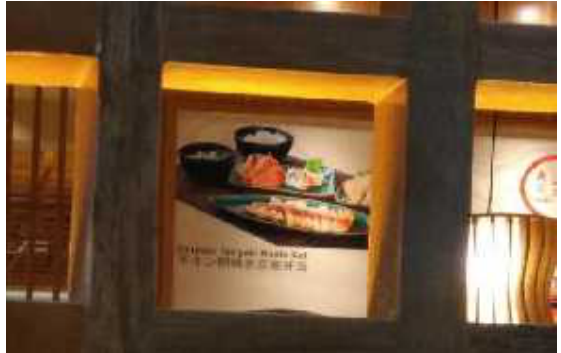
Figure 13. Chicken Teriyaki Bento